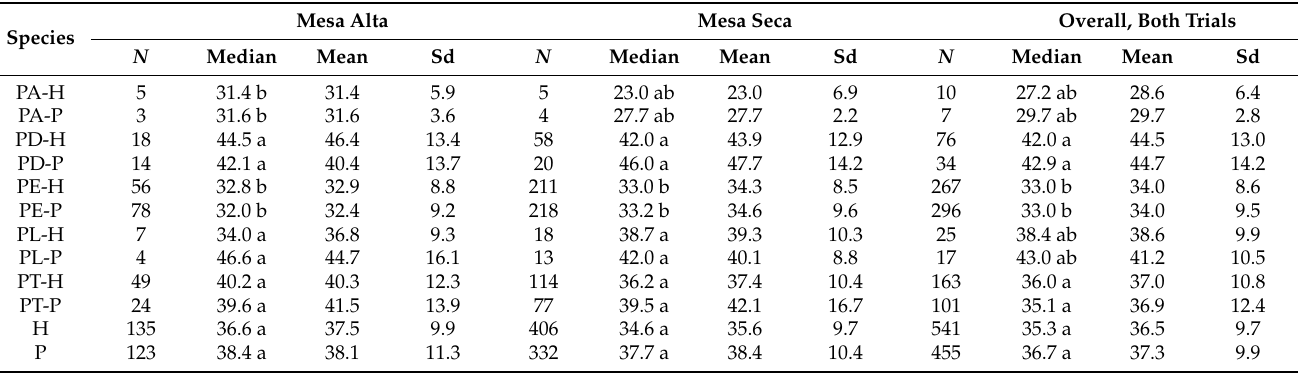
Table 4. Descriptive statistics of the maximum height to the top of the needles (cm) of Pinus seedlings per species and their hybrids, in each trial and both trials together, after growing for 27 months in the